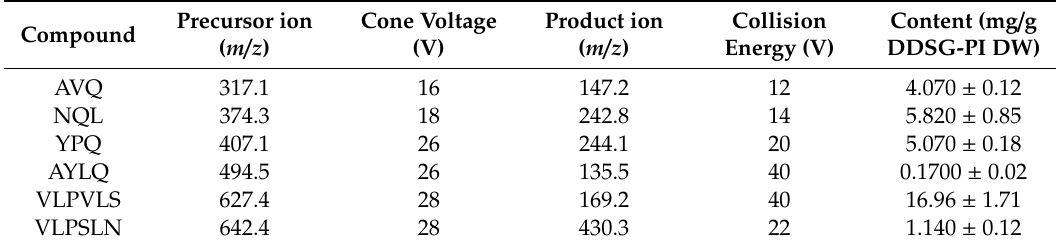
Table 5. Optimal MS parameters of peptide ion pairs using Intellistart in multiple reaction monitoring (MRM) mode and amounts of ACE inhibitory peptides (mg / g) derived from DDSG-PI 1 . Precursor ion Cone Voltage Product ion Collision Content (mg / g Compound ( m / z ) (V) ( m / z ) Energy (V)